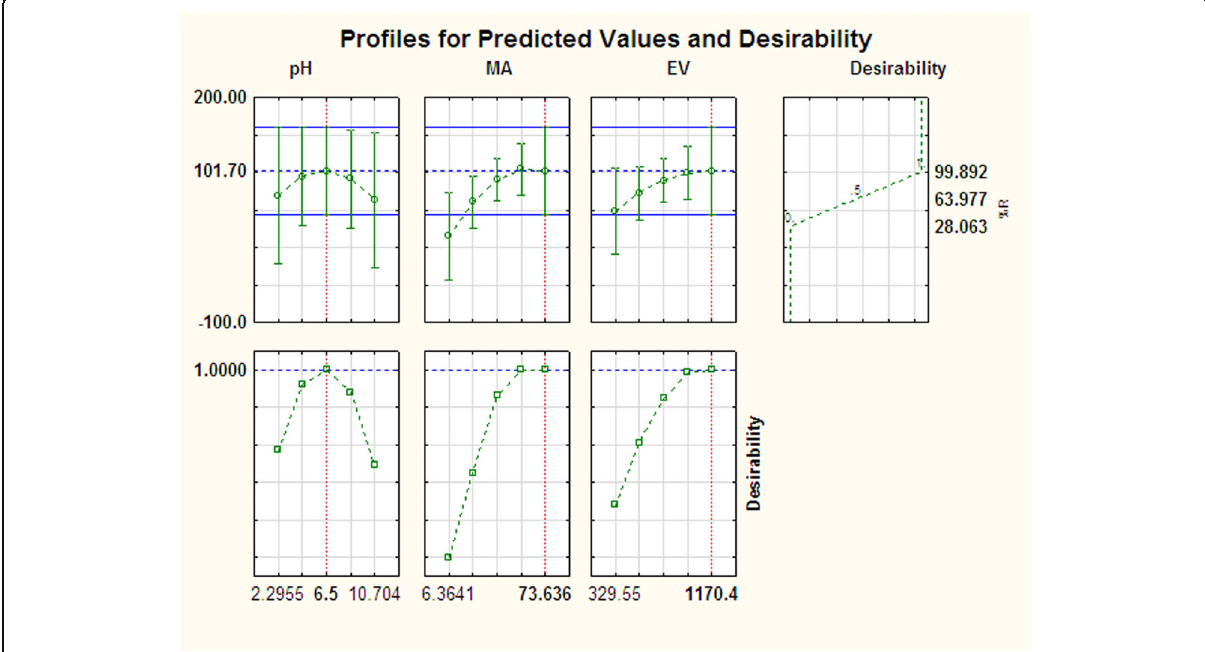
Fig. 9 Profiles for experimental and predicated values and desirability function for the recovery of CBZ